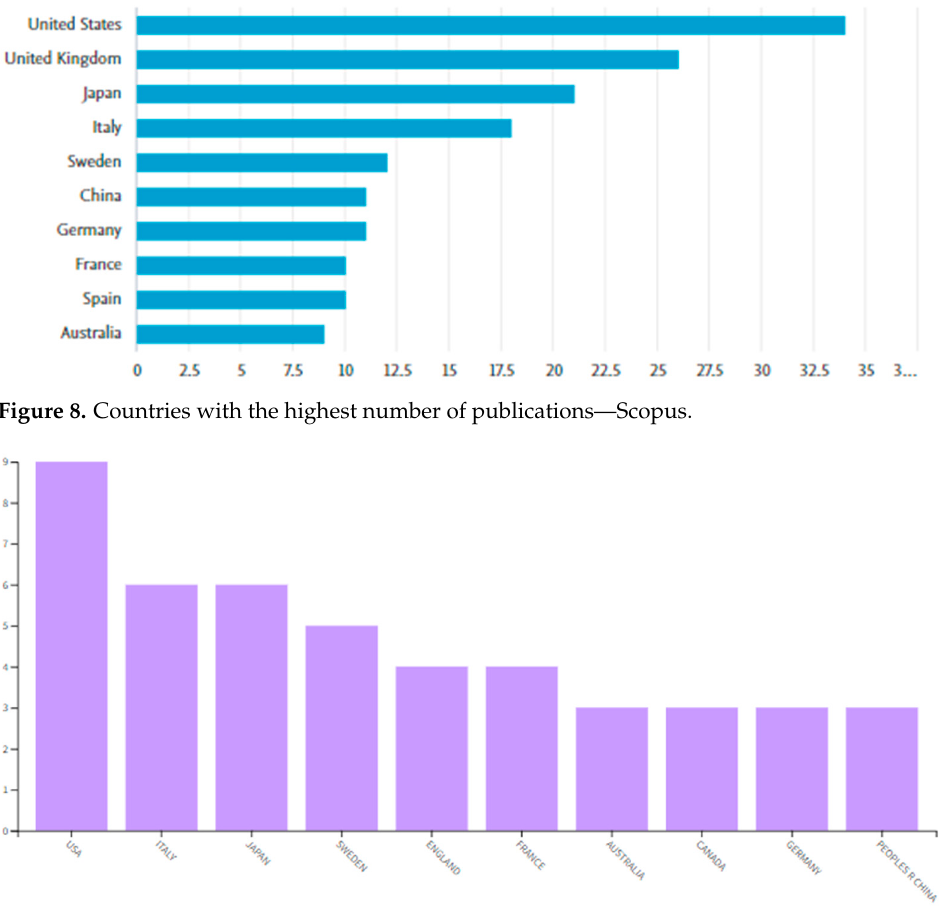
Figure 9. Countries with the highest number of publications—Web of Science.